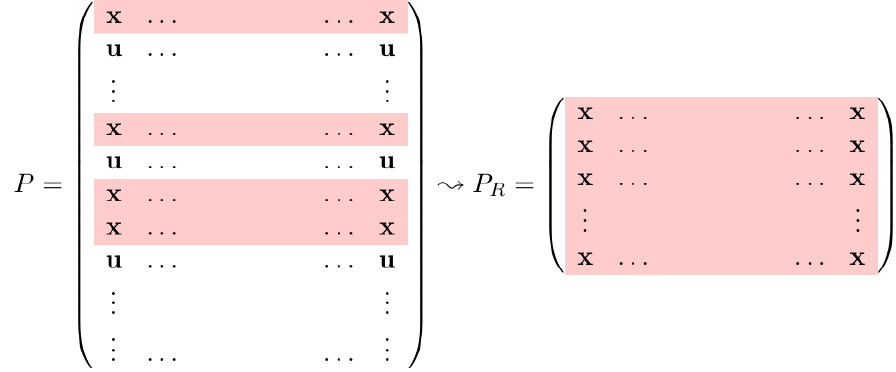
Figure 2: Given the matrix P we delete the unknown rows and obtain P R which is rectangular. The matrix P R has k rows and n columns.